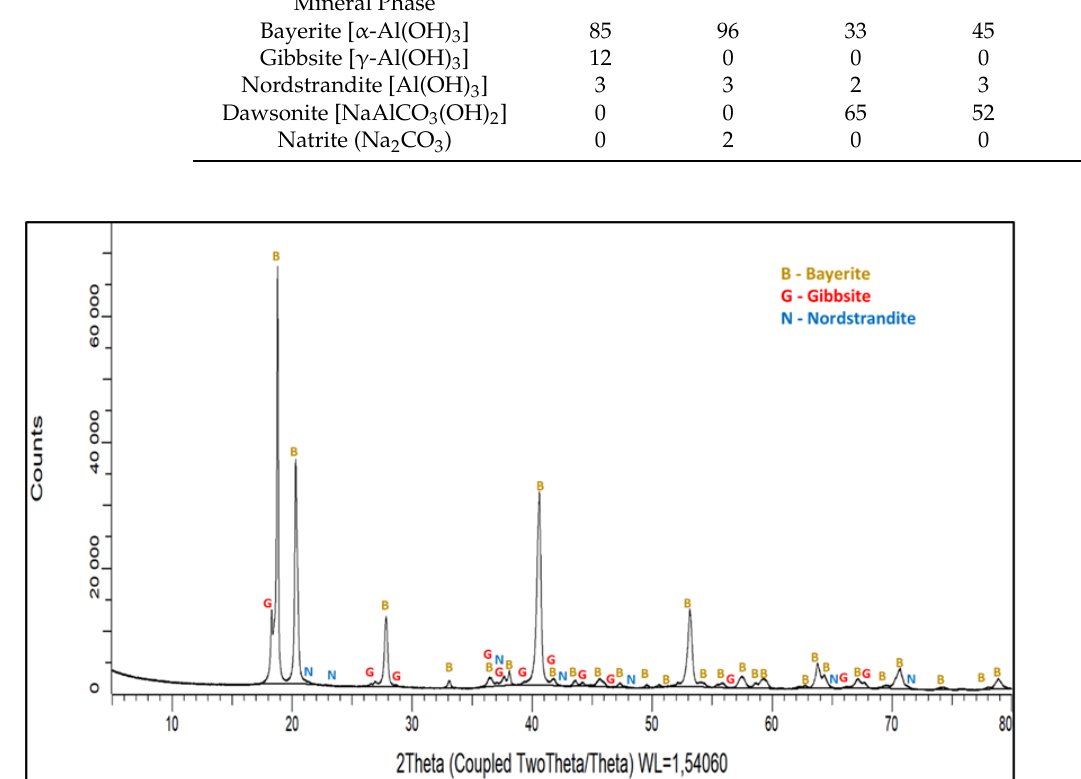
Table 10. Quantitative XRD analysis of phases in the precipitation filter cake (wt%). Table 10 . Quantitative XRD analysis of phases in the precipitation filter cake (wt%) . Solution Leach Test No. Solution Leach Test No.